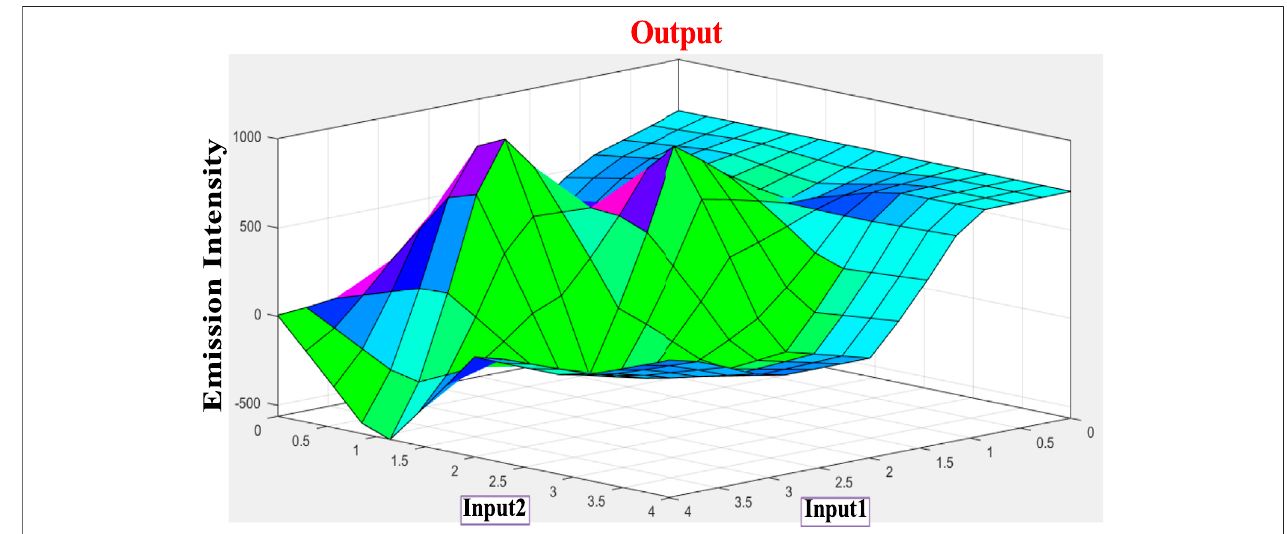
FIGURE 12 | Three-dimensional representation (based on Sugeno ’ s method) of the dependence of emission intensity of tpy-HImzPh 3 at 485 upon simultaneous action of two inputs (F − and H + ).